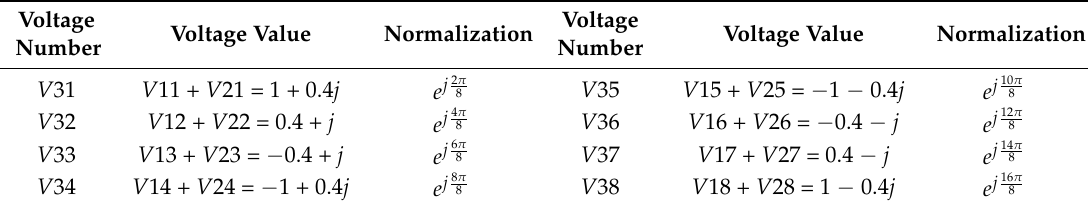
Table 3. The voltage distribution of LVPEs for transmitting spiral sound waves using a two dipole sound field.